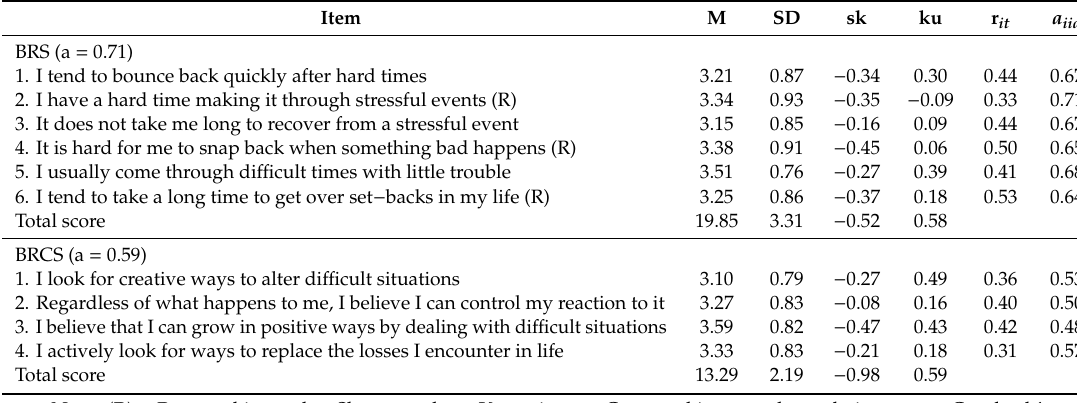
Table 1. Descriptive statistics of the Brief Resilience Scale (BRS) and Brief Resilient Coping Scale (BRCS)